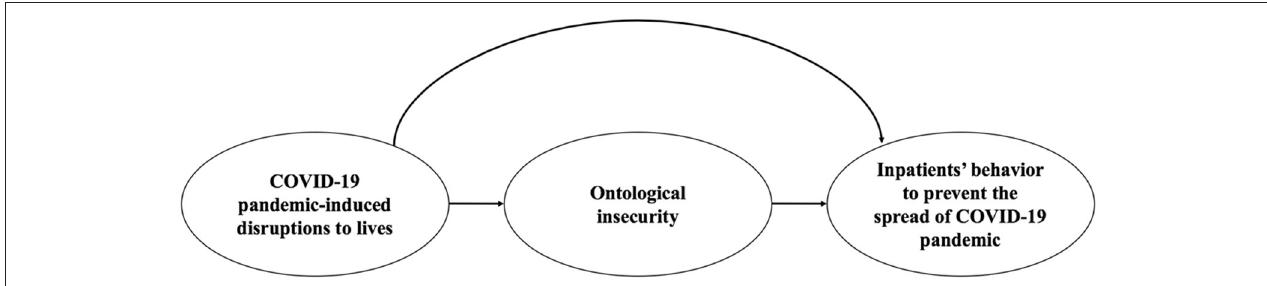
FIGURE 1 | A framework of the relationship between the COVID-19 pandemic-induced disruptions to inpatients’ lives, ontological insecurity, and patients’ behavior to prevent the spread of the COVID-19 pandemic.